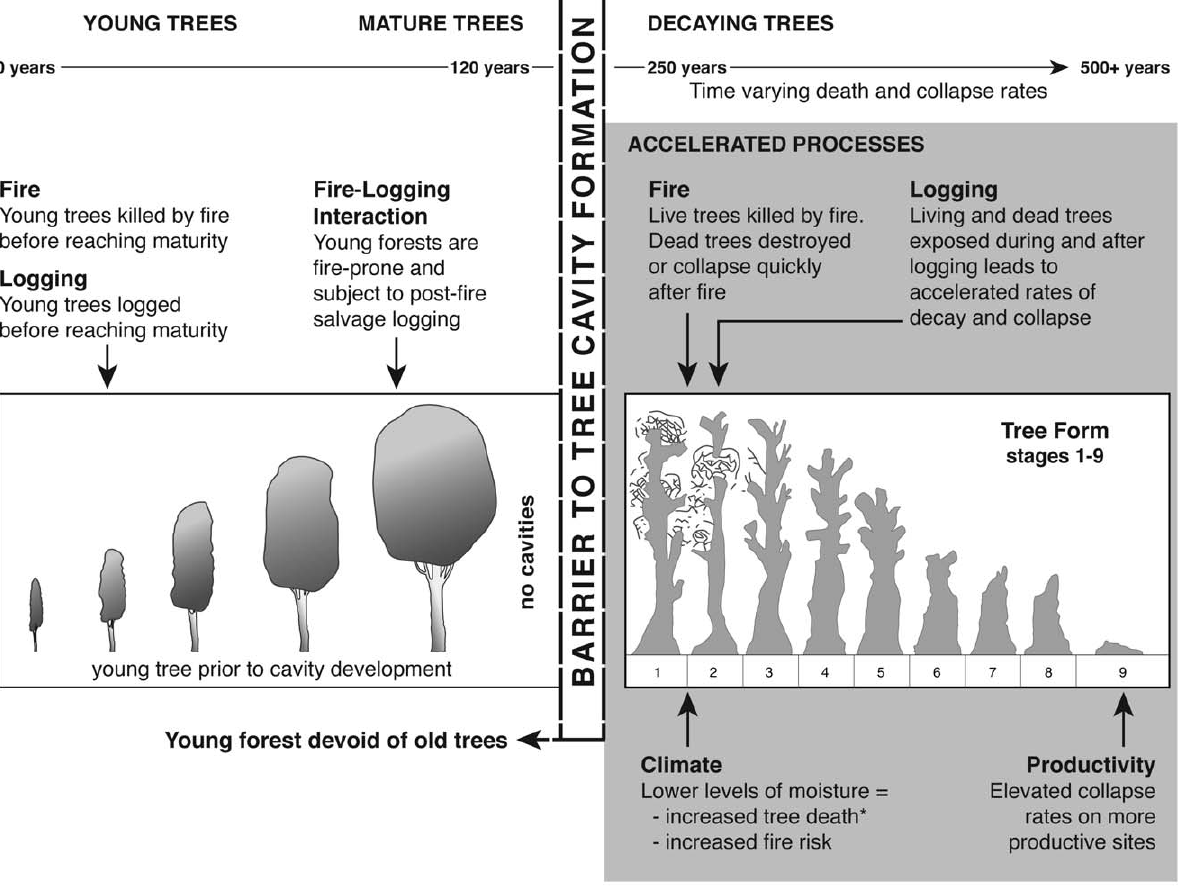
Figure 8. Conceptual model of the key processes influencing large cavity tree death and collapse. The processes include (1) natural disturbance (fire), (2) human disturbance (logging), (3) fire-logging interactions, (4) climate (although the effects of the moisture index on tree death were marginal in this study as indicated by the star * in the model), (5) productivity, and (6) time (as indicated by time varying death and collapse rates). These factors are underpinning accelerated large cavity tree loss and impaired large tree recruitment in Mountain Ash forests.